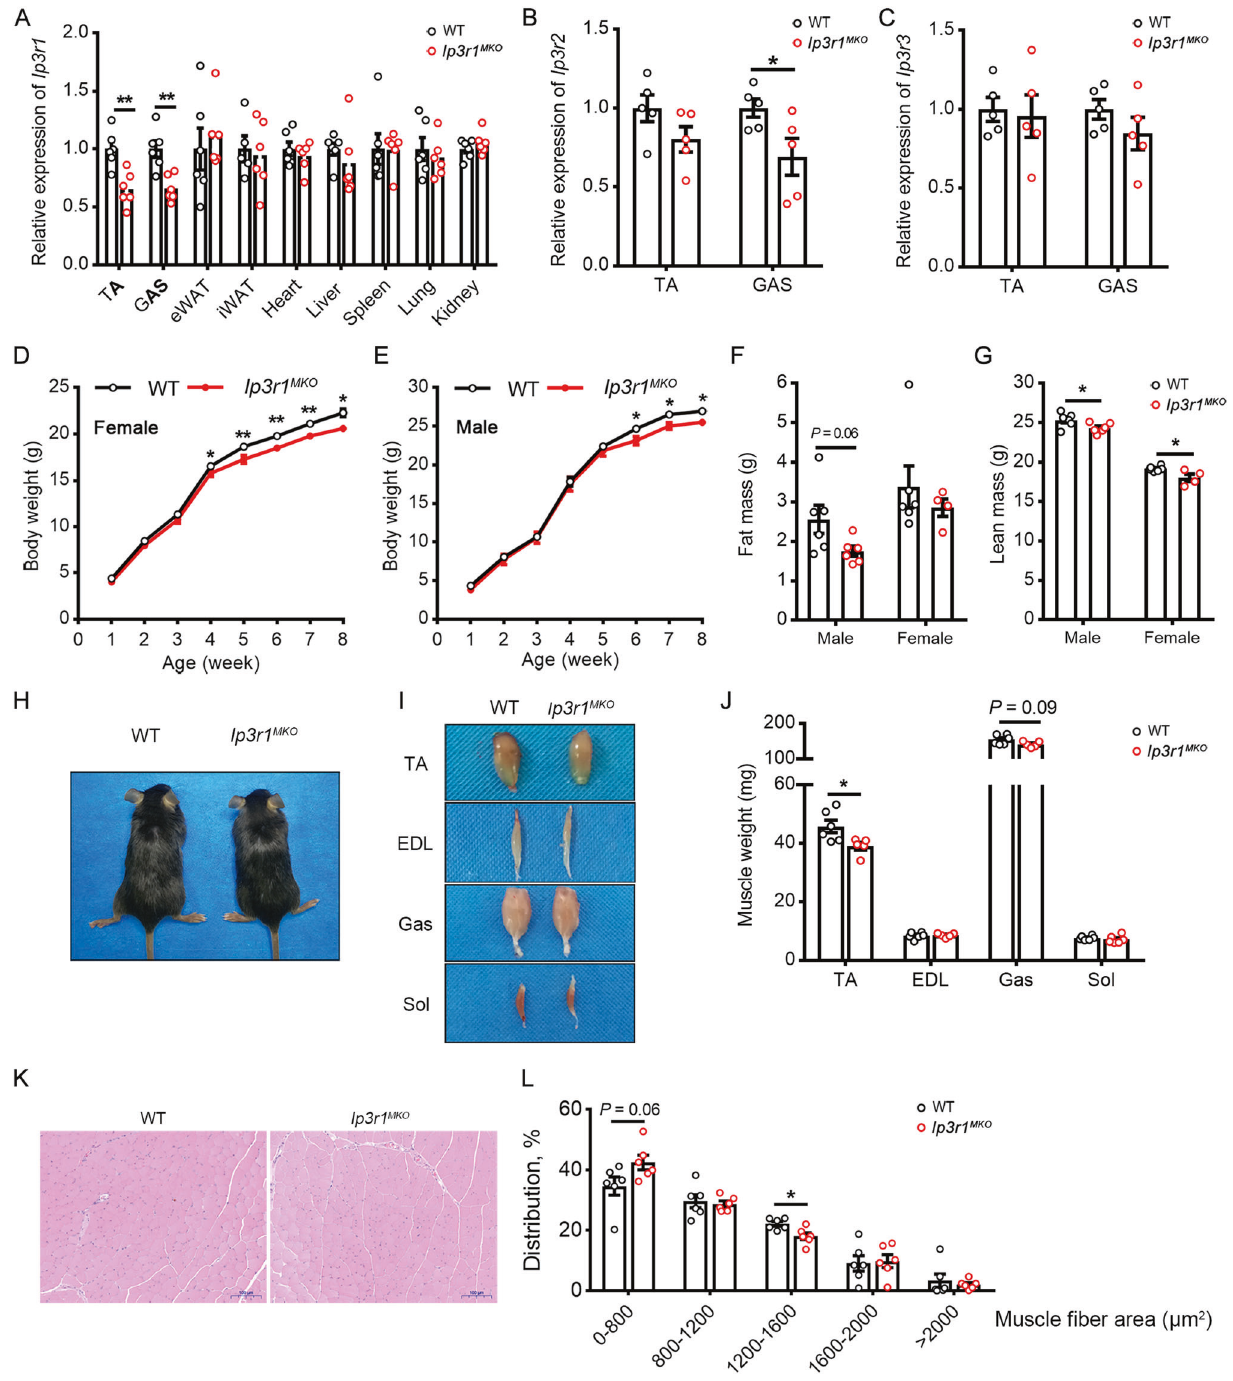
Fig. 2 Ip3r1 deletion in skeletal muscle leads to lower muscle weight. A mRNA expression levels of Ip3r1 in skeletal muscle (TA and GAS), adipose tissues (eWAT and iWAT), heart, liver, spleen, lung and kidney ( n = 6). B , C Relative mRNA expression levels of Ip3r2 and Ip3r3 in TA and GAS isolated from WT and Ip3r1 MKO mice ( n = 5). D , E Body weight curve of WT and Ip3r1 MKO female and male mice ( n = 10). F Fat mass and ( G ) lean mass of adult WT and Ip3r1 MKO female and male mice measured by the nuclear magnetic resonance system ( n = 4 – 6). H , I Representative images of size and TA, EDL, GAS and Sol muscles in adult WT and Ip3r1 MKO mice. J Muscle weight of adult WT and Ip3r1 MKO mice ( n = 5). K H&E staining of TA muscles and ( L ) frequency histogram of fi ber cross-sectional area ( n = 6). Scale bar = 100 µm. All data were analyzed by two- tailed unpaired Student ’ s t test and presented as means ± SEM. * P < 0.05, ** P <